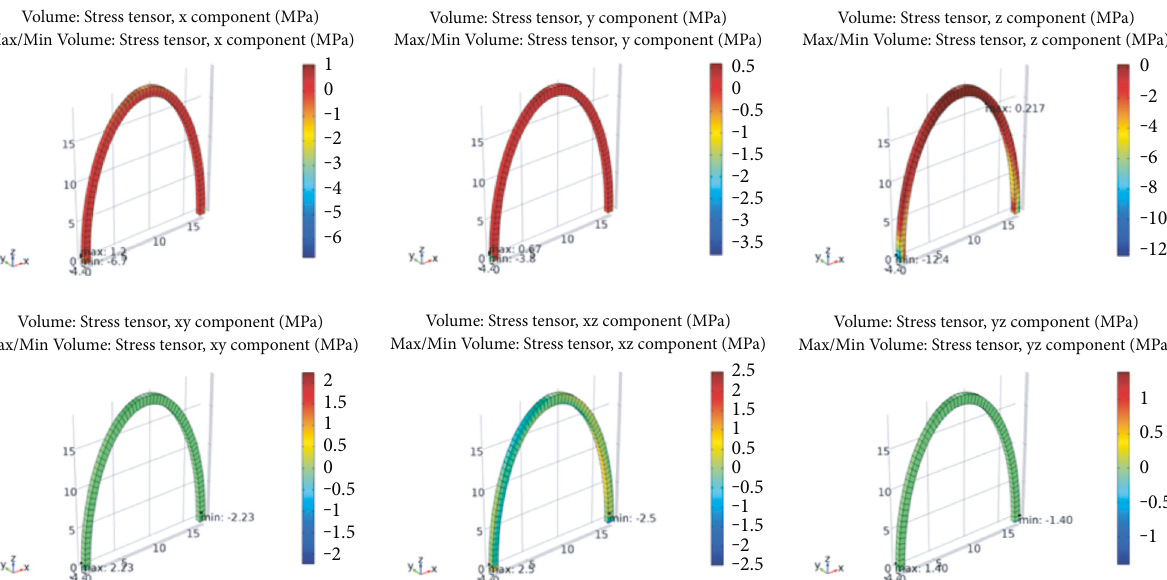
Figure 5: Maximum value and location of the standard and shear stress components in the global coordinate system.